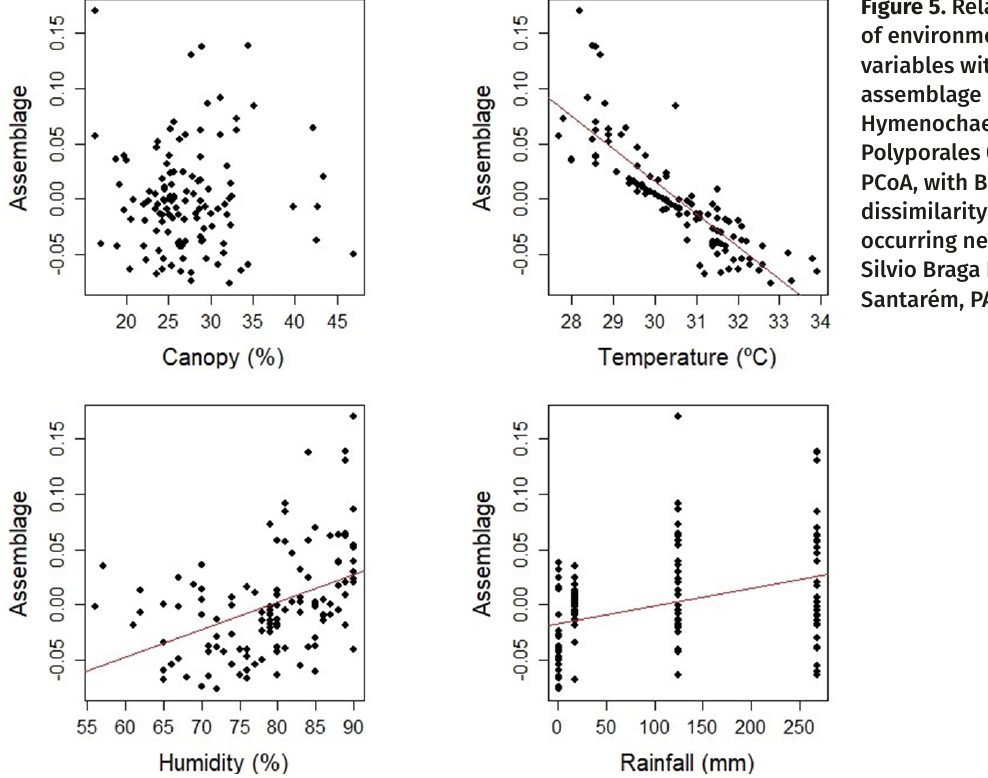
Figure 5. Relationship of environmental variables with the assemblage of Hymenochaetales and Polyporales (axis 1 of PCoA, with Bray-Curtis dissimilarity distance) occurring near the Silvio Braga HPP, Santarém, PA.